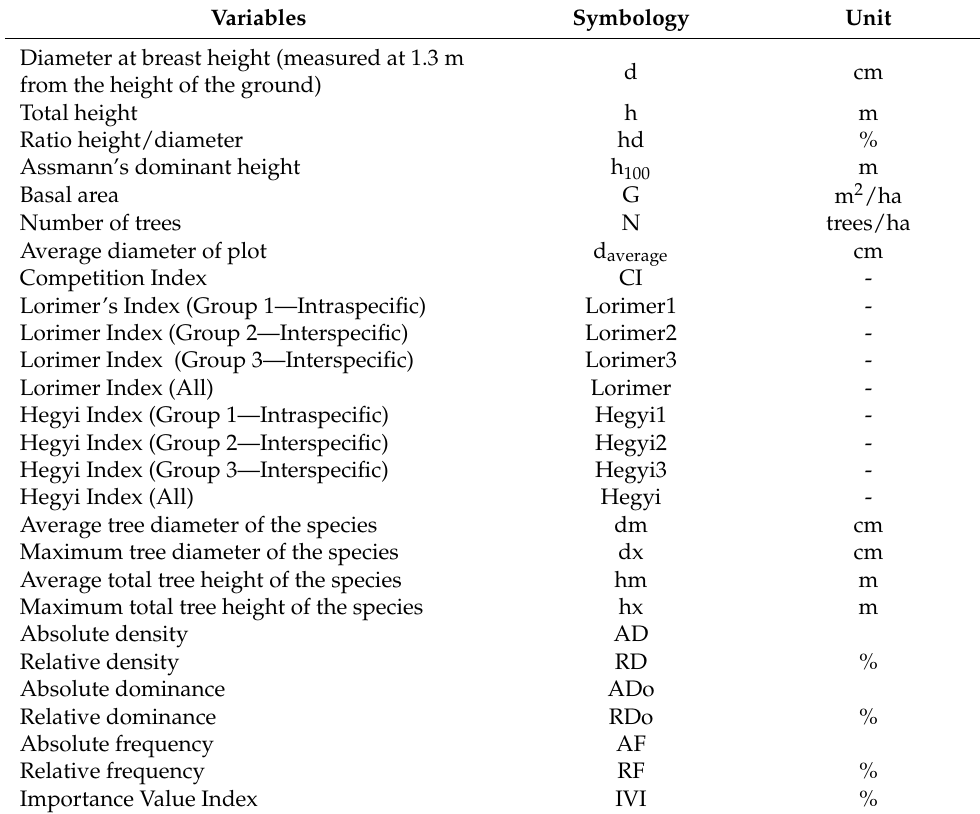
Table 1 gathers the definitions used in this long study. Table 1. Definitions of symbols and units used along this study. Variables